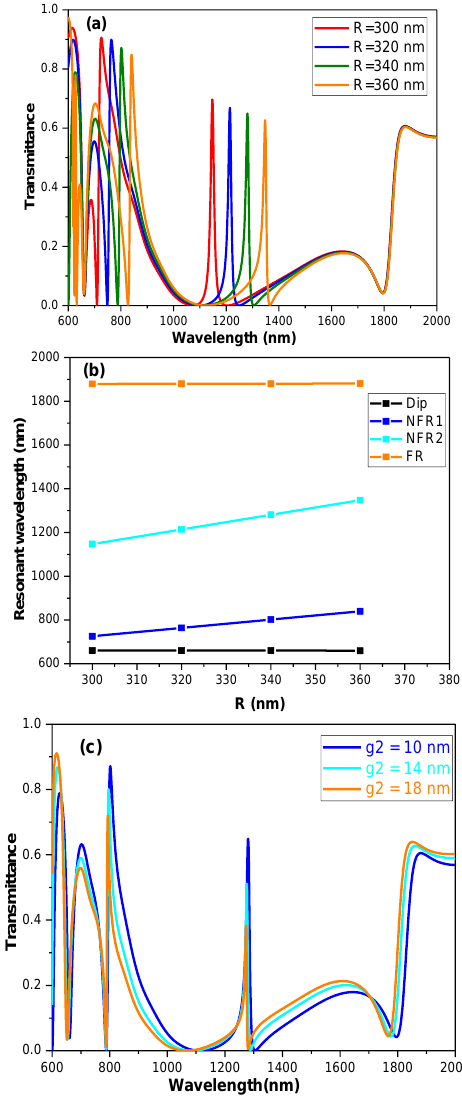
Figure 3b. It can be observed that Dip and FR keep fixed through changing R while NFR1 and NFR2 both make a linear redshift. It is consistent with Figure 2d–g, which show that NFR1 and NFR2 come from the circle cavity modes but Dip and FR arise from the coupling of the two stubs. Additionally, the coupling distance g2 is adjusted to better control the extend system, which is shown in Figure 3c. Figure 3c witnessed little changes on the resonant wavelengths of Dip, NFR1, NFR2 and FR. However, the transmittance of NFR1 and NFR2 decreased gradually with increasing g2 but FR observed the converse result. This can be explained in Figure 2d–g. The decreasing of NFR1 and NFR2, coming from the circle cavity modes, is caused by the weakened coupling between stubs and the circle cavity with increasing g2. However, FR mainly originates from the coupling of the two stubs, therefore, it is easy-to-understand for the converse change. Based on the adjusting of the structure parameters, the extended system can be better controlled and tuned.